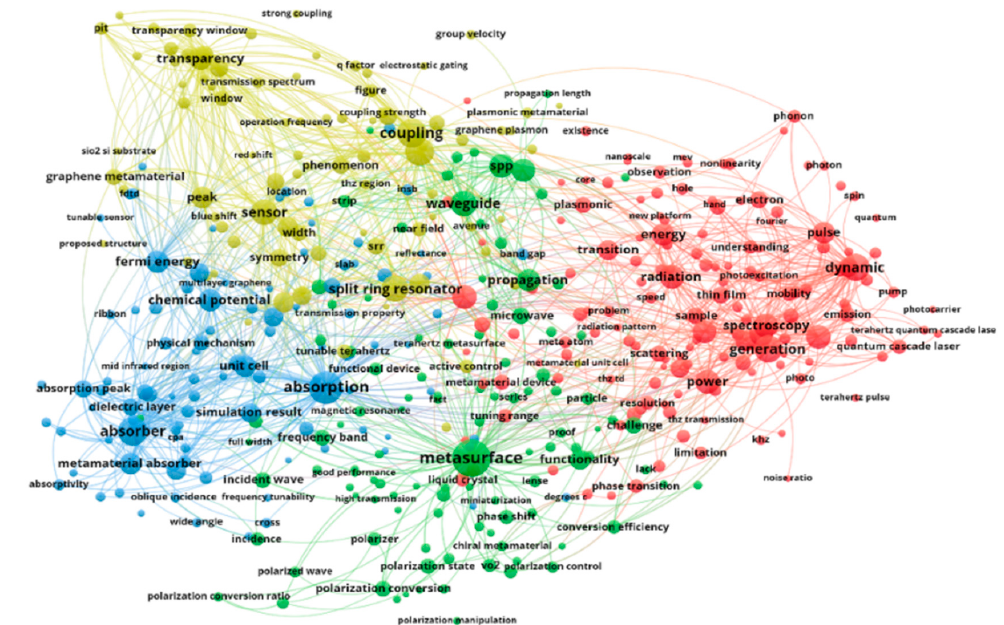
Figure 2. Keyword diagrams in terahertz papers, where the circle size represents the keyword heat.